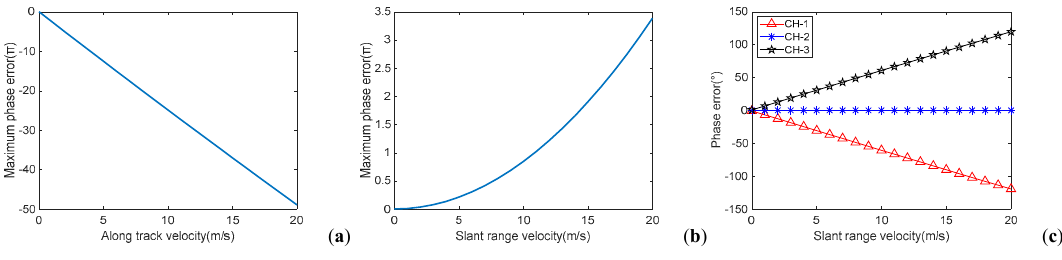
Figure 8. The influence of the velocity of the moving target. ( a ) The maximum phase error caused by the along track velocity. ( b ) The maximum phase error due to the slant range velocity. ( c ) Azimuth multichannel phase imbalance due to the slant range velocity.